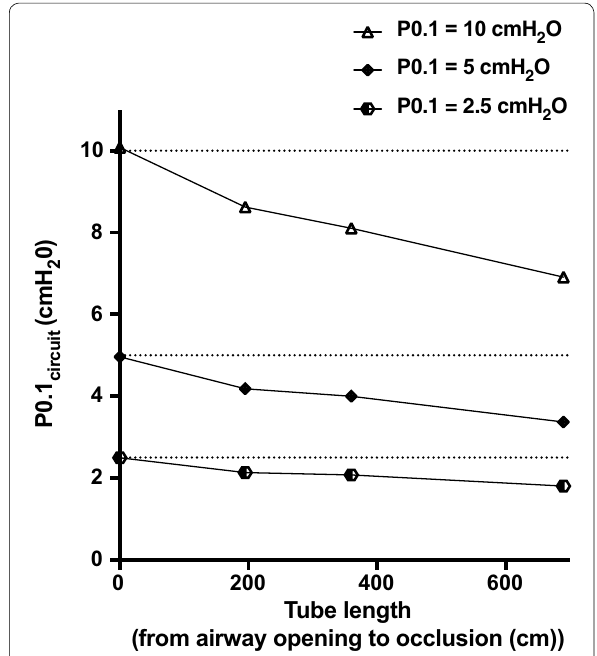
Fig. 4 P0.1 measurements (P0.1 circuit ) according to the position of the airway occlusion. P0.1 circuit measurements were performed with occlusions at different positions (i.e., at 0, 195, 360 and 690 cm from the airway opening). The second compartment of the test lung was occluding using a hermetic plug placed at the airway opening or on a circuit tube of 195, 360 or 690 cm connected to the airway opening. Dotted lines represent P0.1 values of 2.5, 5 and 10 cm H 2 O,